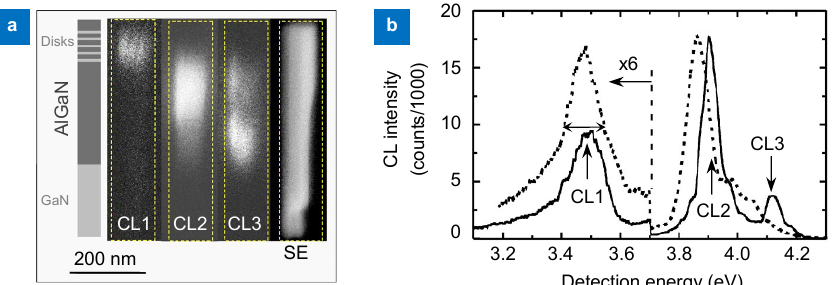
Fig. 4 | ( a ) Schematic, CL images and SEM image of the single nanocolumn. ( b ) CL spectra of two single GaN/AlGaN nanocolumns. Figure reproduced from ref. 59 , AIP